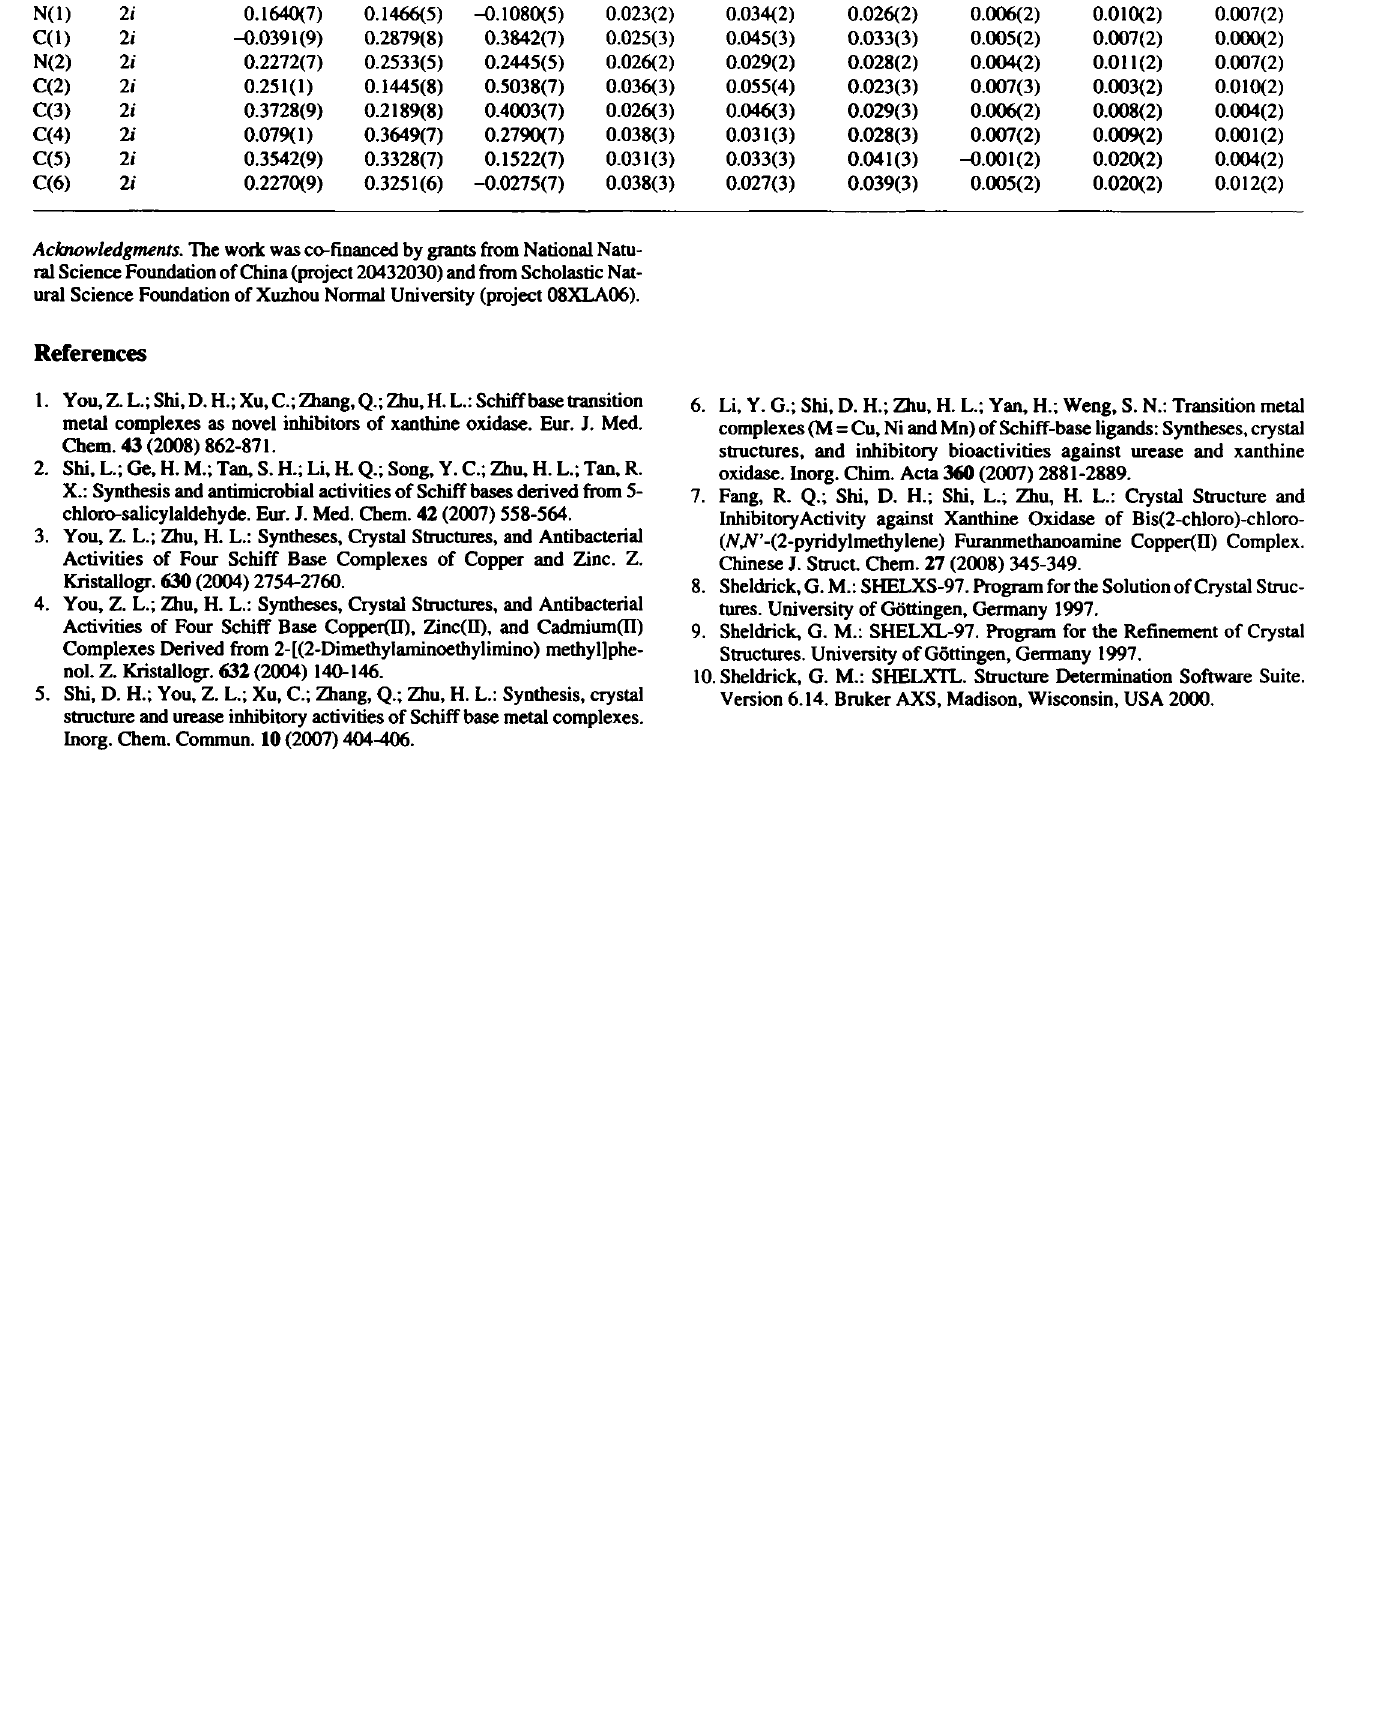
Table 3. Atomic coordinates and displacement parameters (in Â 2